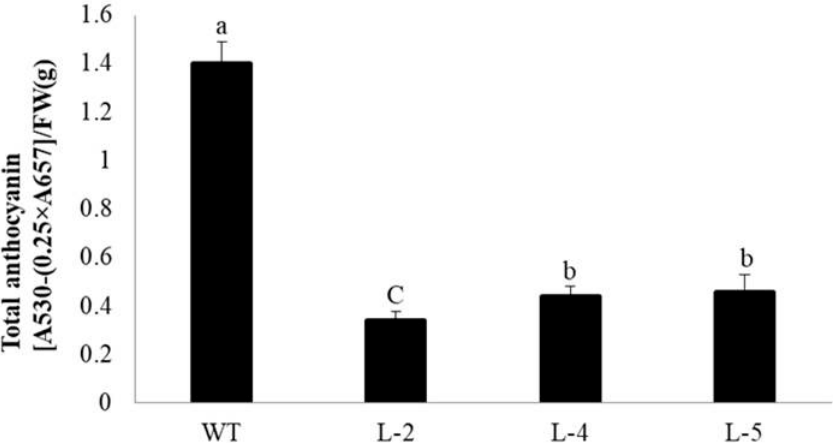
Figure 5. Estimation of total anthocyanin in wild type and transgenic lines (L-2, L-4, and L-5). The bars represent the standard error of thrice biological replication. Small letters showed a significant difference at the level of p < 0.05 by using LSD statistical analysis.